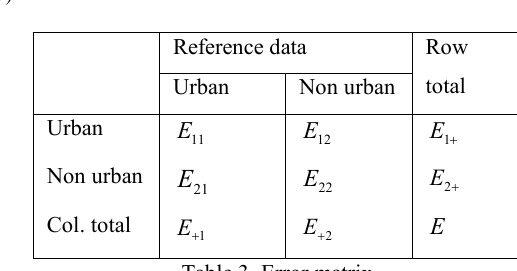
Table 3. Error matrix